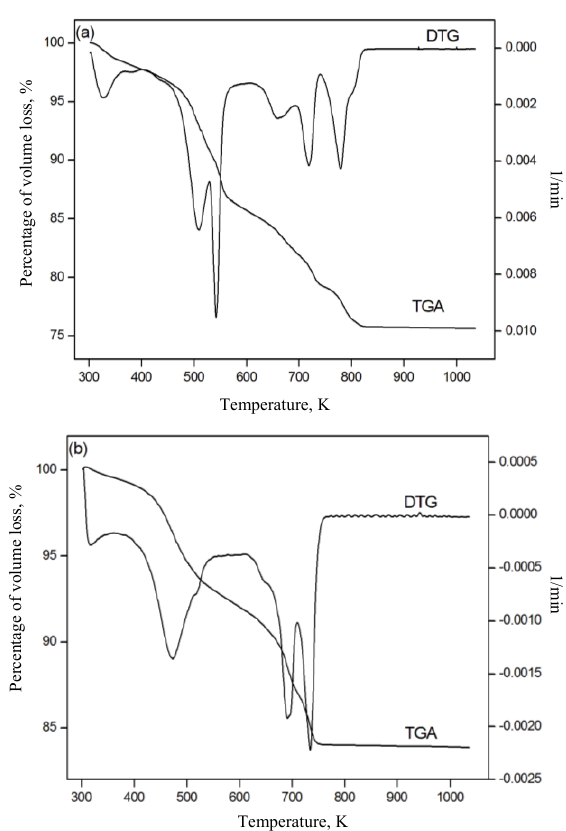
Figure 3 . Thermogravimetric analysis (a) BBN and (b)